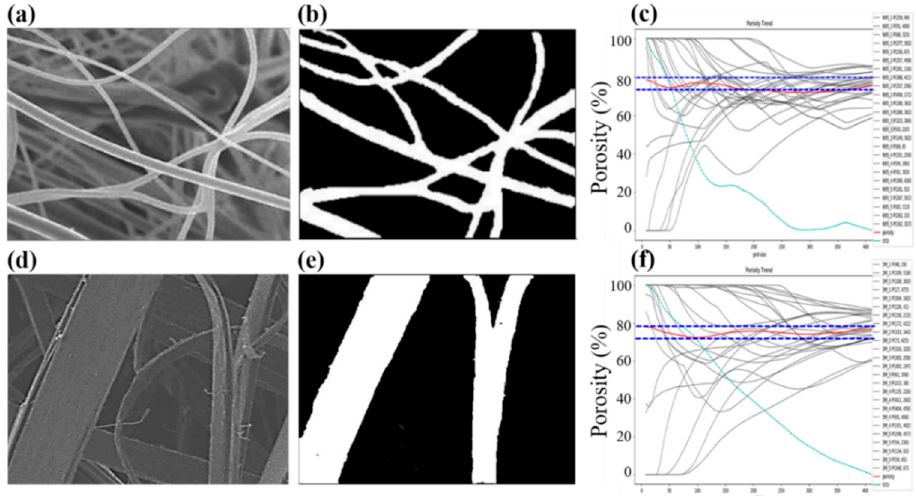
Figure 5. The original SEM image, GrabCut processed image, and REA result of the N95 mask in ( a ), ( b ), and ( c ); those of the 3M filter in ( d ), ( e ), and ( f ), respectively.